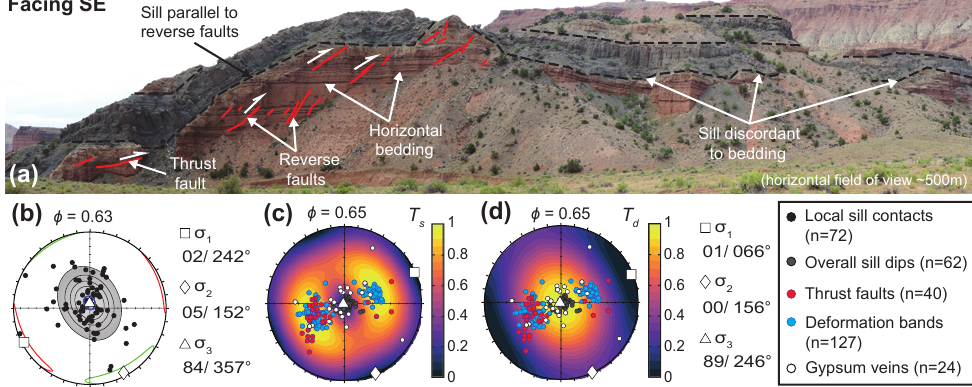
Figure 8. Sill geometry and paleostress analyses of deformation structures in the San Rafael subvolcanic field. (a) Field example for compar- ison between sill and thrust-fault geometry. (b–d) Lower-hemisphere equal-area projections with calculated stress axes given as plunge–trend measurements. (b) Local sill–host rock contact data; Bingham analysis (Yamaji, 2016) used to calculate principal stress axes, shown with 95% confidence regions and density contours (shaded region). Panels (c) and (d) are mechanical models contoured for slip tendency ( T s ) and dilation tendency ( T d ),